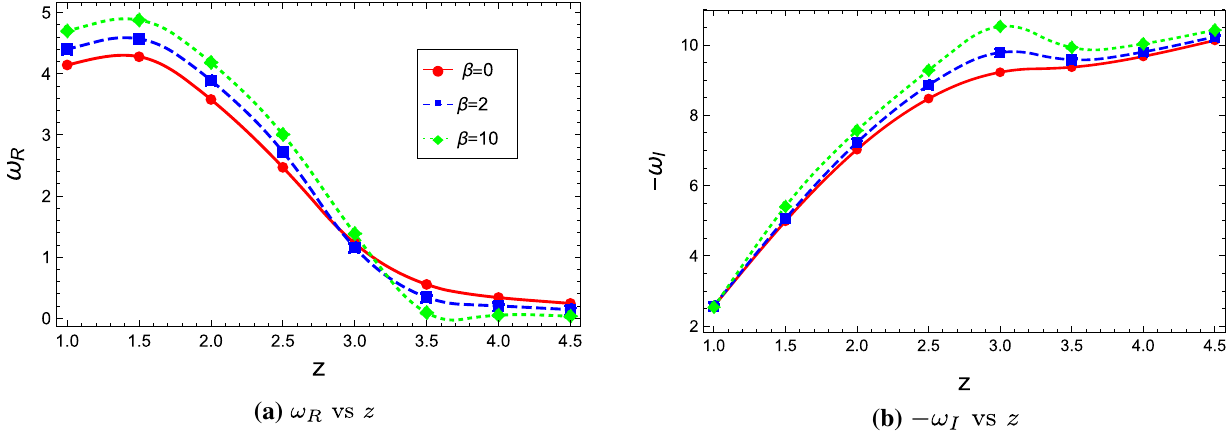
Fig. 3 The behaviors of real and imaginary parts of QNFs vs z for different β where d = 5, m = 3, q = 1, m 2 s = 1 / 4 and q s = 2